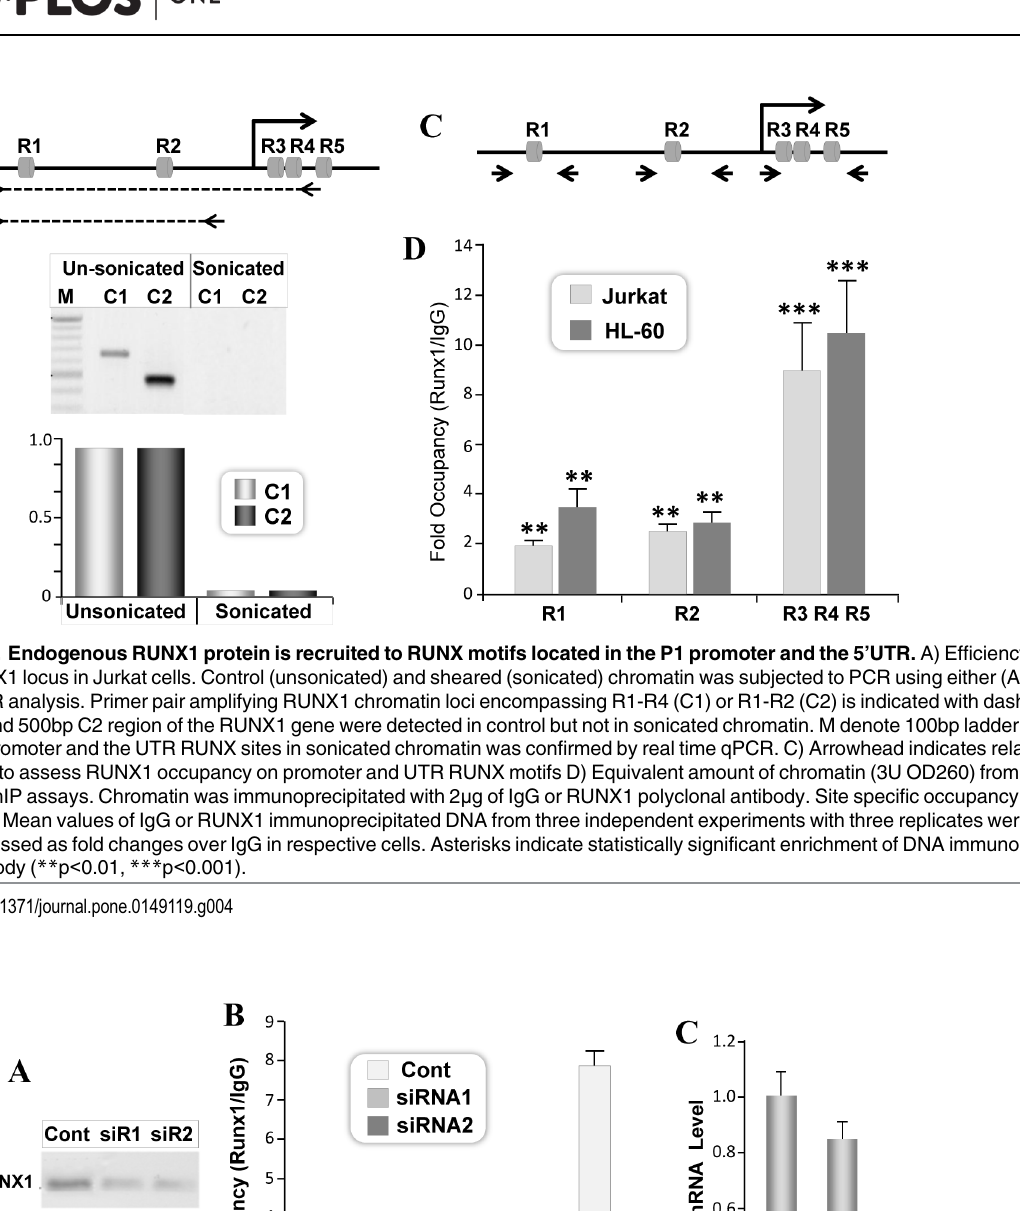
PLOS ONE | DOI:10.1371/journal.pone.0149119 February 22,